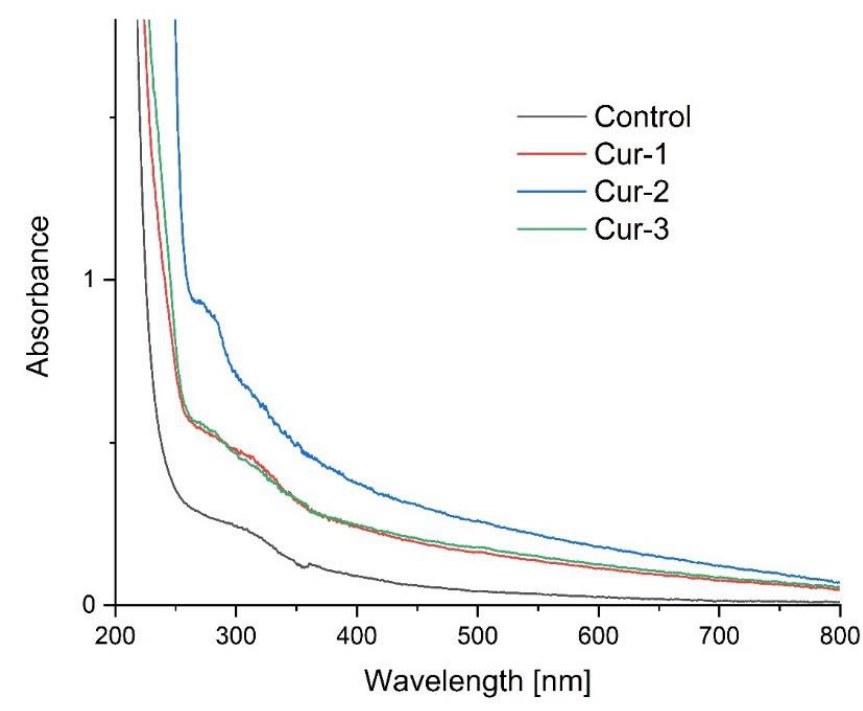
Figure 3. UV-Vis spectra of the control film and composites containing nanocapsules.